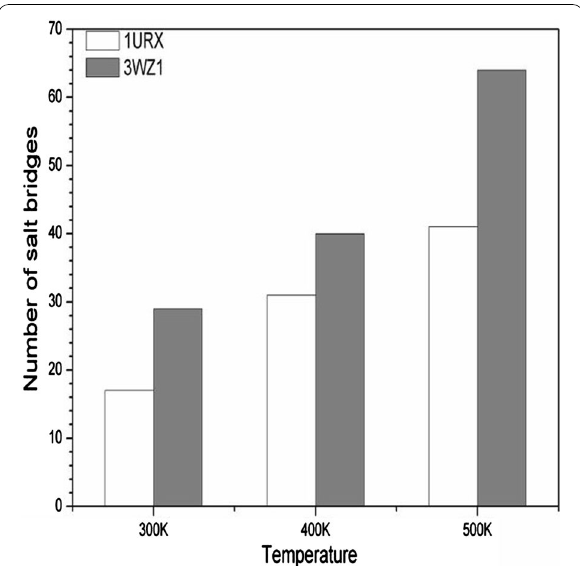
Fig. 7 Number of salt bridges in 1URX and 3WZ1 at different